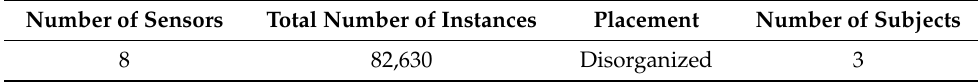
Table 2. Description of DS2 .